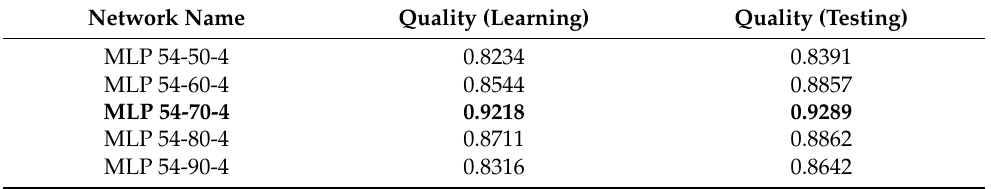
Figure 5. Values of the mean square error (MSE) during learning: ( a ) optimal MLP 54-70-4, ( b ) non-optimal MLP 54-90-4. Table 8. Selected ANNs quality